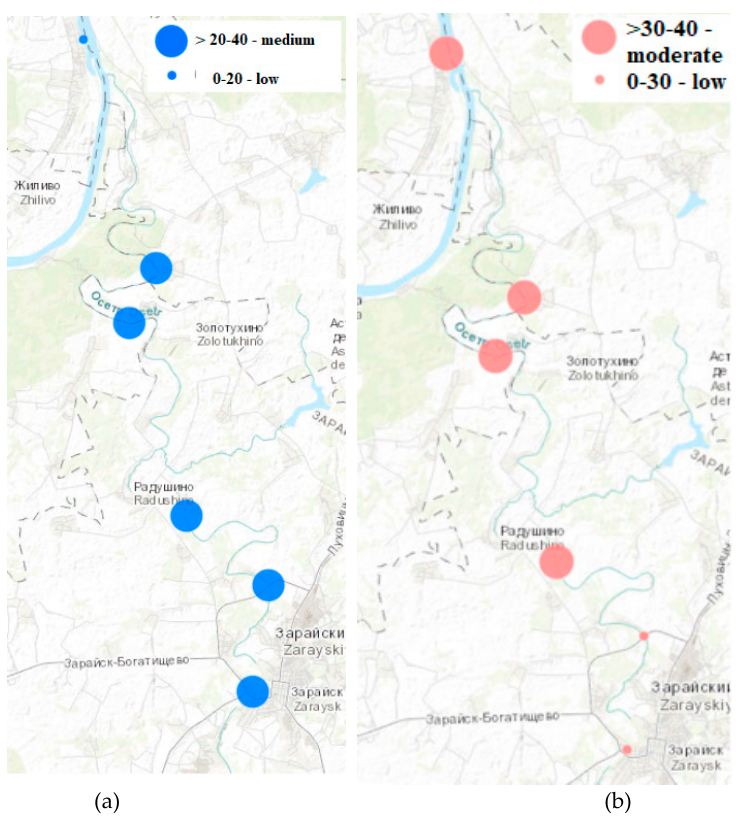
Figure 2. Map charts of the human-induced load areas in the Osetr and Oka river sections for 2018: ( a ) In terms of the human-induced load degree; ( b ) In terms of the amount of the human-induced